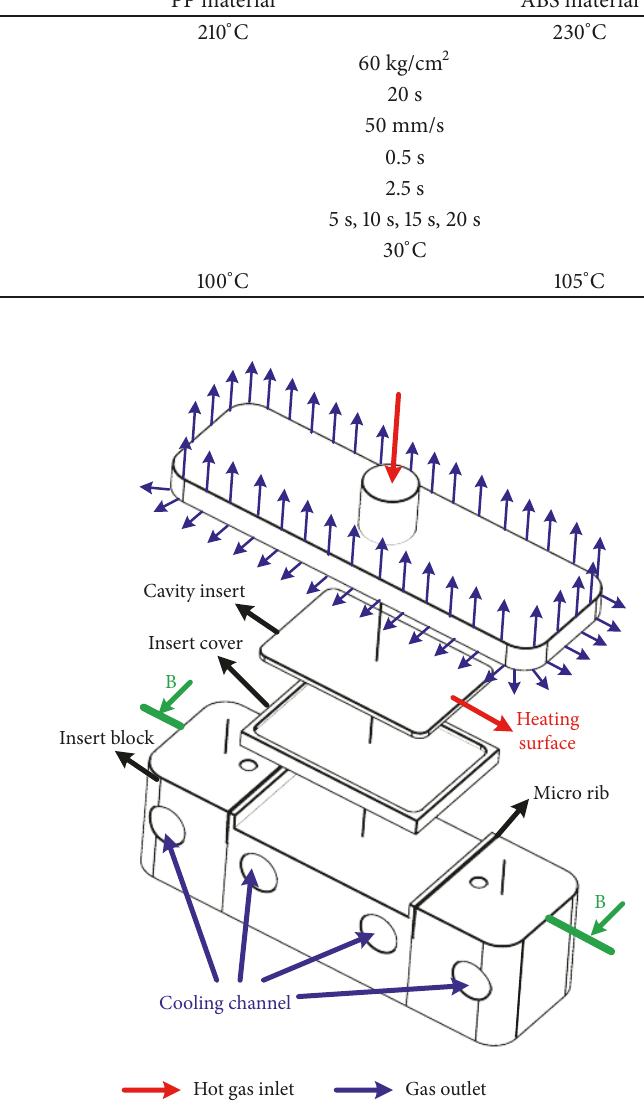
Figure 10: Simulation model of thin rib heating